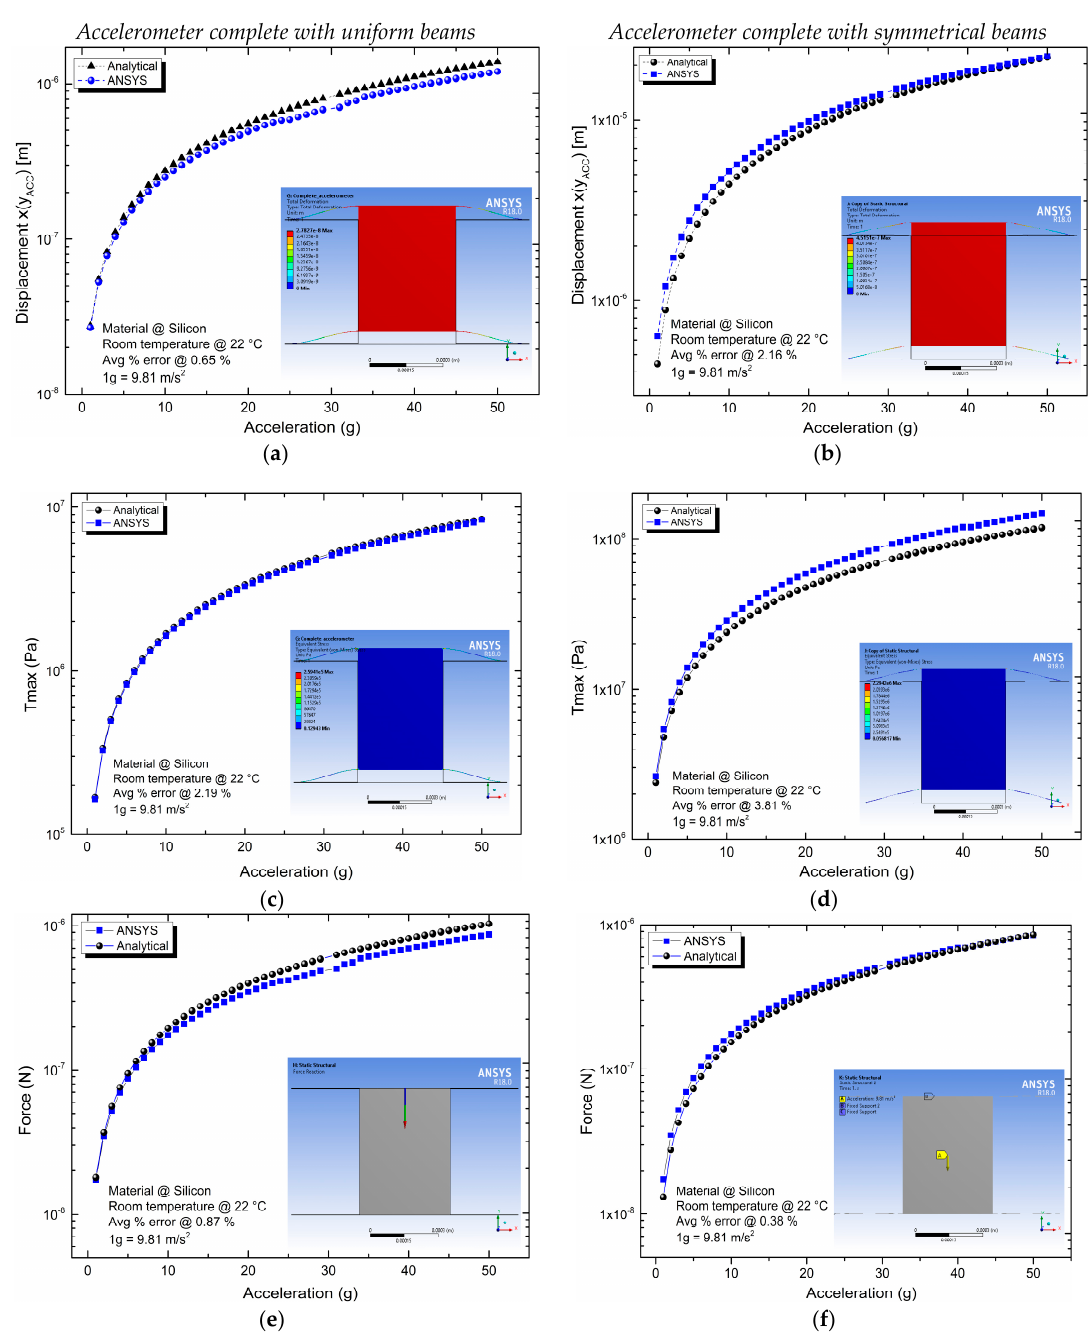
Figure 4. Simulated parameter values of the complete accelerometers with uniform and symmetrical beams, respectively, considering a sweep on applied acceleration from 1 to 50 g. ( a , b ) Displacement of guided ends. ( c , d ) Maximum stress at clamped ends of beams. ( e , f ) Force applied to the guided end.